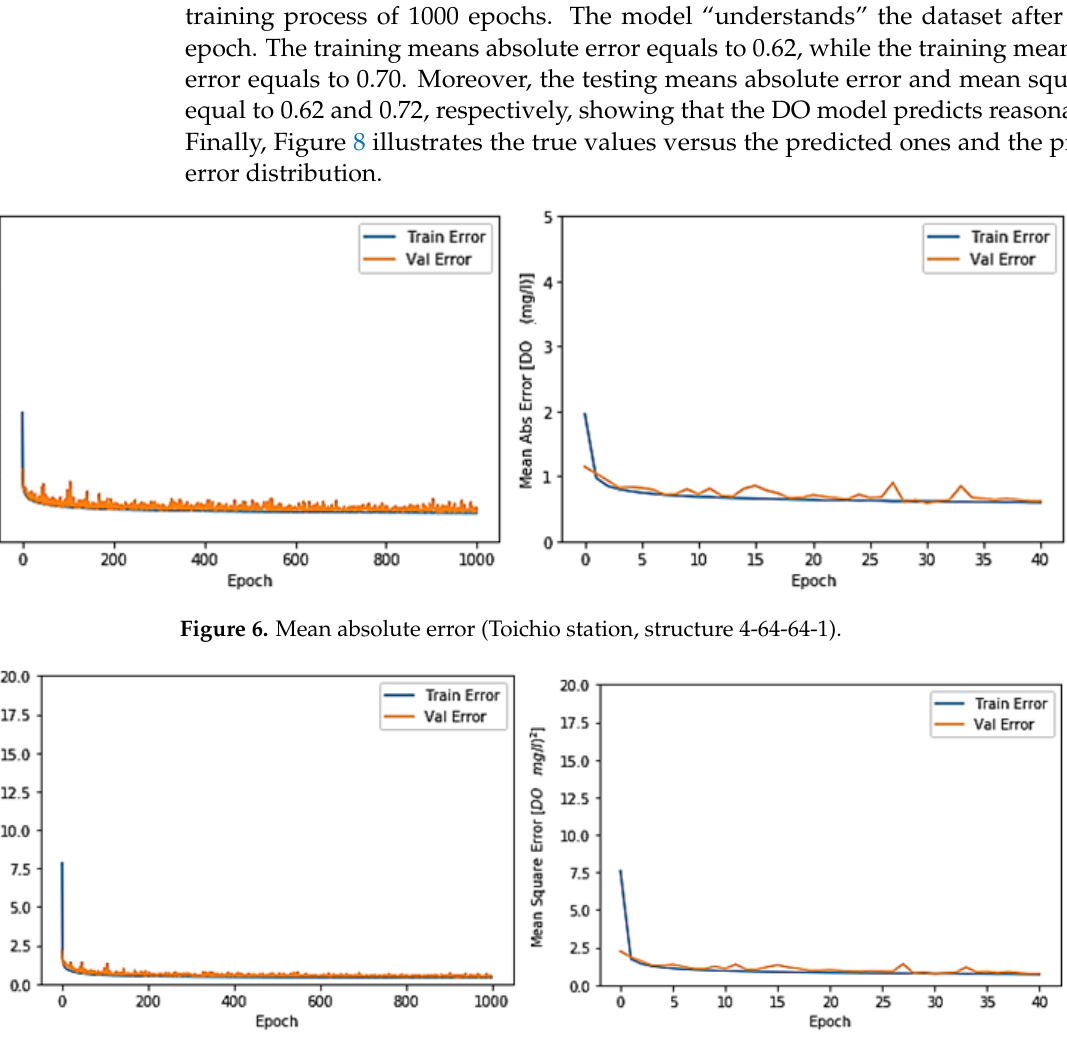
Figure 5. True vs. predicted values ( left ); predicted error ( right ) (Toichio station, structure 7-64-64-1).